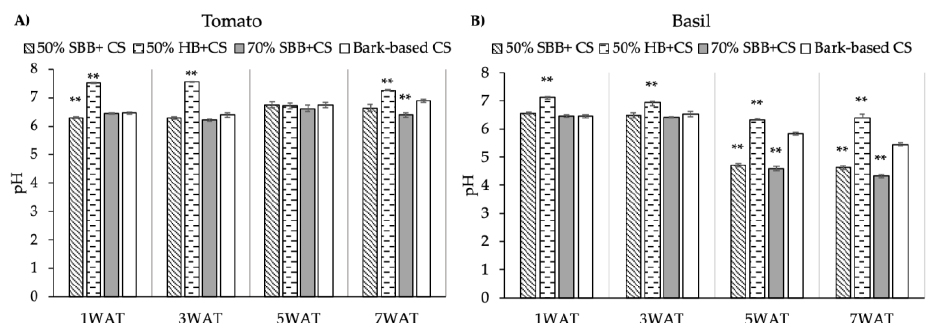
Figure 2. The pH (mean ± standard error) of container mixes, with 50% sugarcane bagasse biochar (SBB), 50% mixed hardwood (HB), and 70% SBB (by vol.) mixed with bark-based commercial substrate (CS) grown with tomato ( A ) and basil ( B ) plants at 1, 3, 5, and 7 week(s) after transplantation (WAT). **indicated significant di ff erences from CS using Dunnett’s test at p ≤ 0.01.